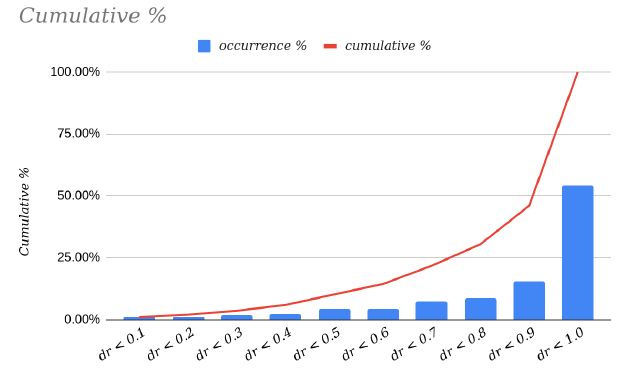
Figure 7. Graphical representation of the data in Table 1.